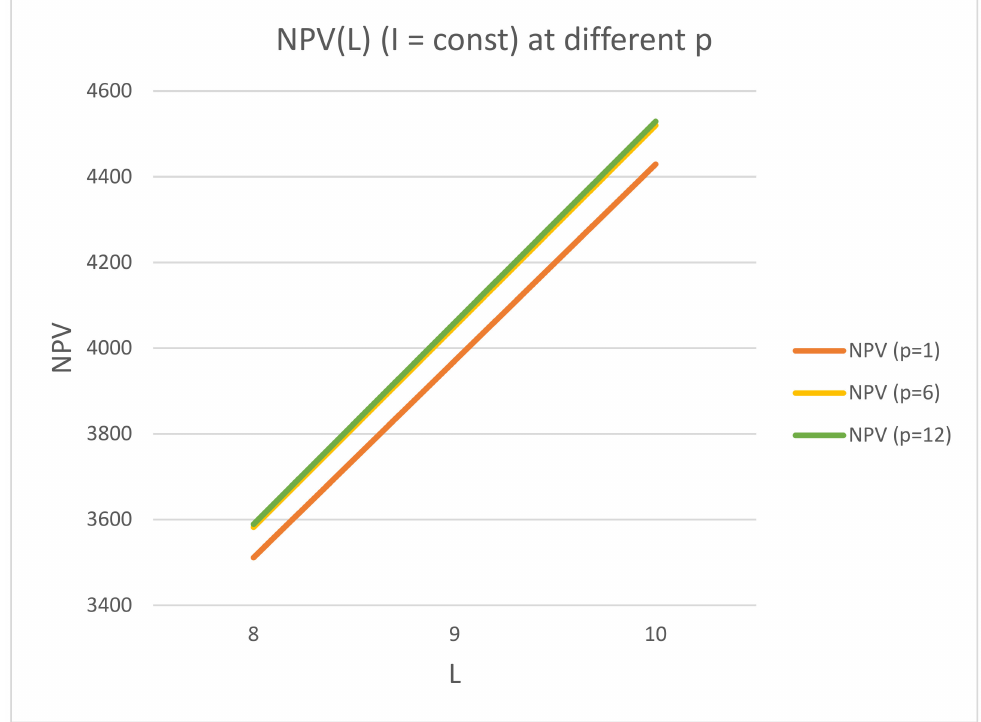
Figure 11. Dependence of NPV on leverage level L at k 0 = 0.22, k d = 0.14 and different p = 1, 6, 12 for a three-year project (larger